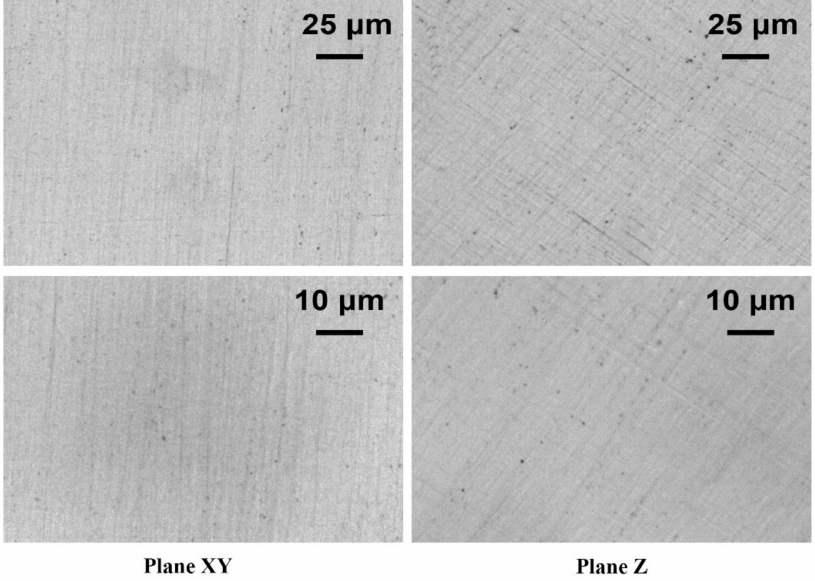
Figure 3. Optical images of the sample produced with laser power of 195 W, scan speed of 1000 mm / s, and hatching distance of 0.05 mm /